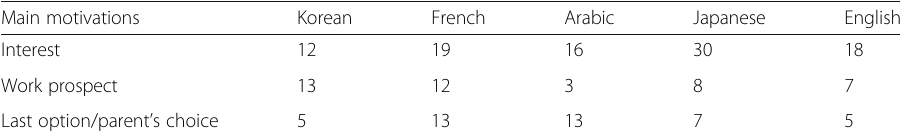
Table 12 Reasons in choosing the foreign